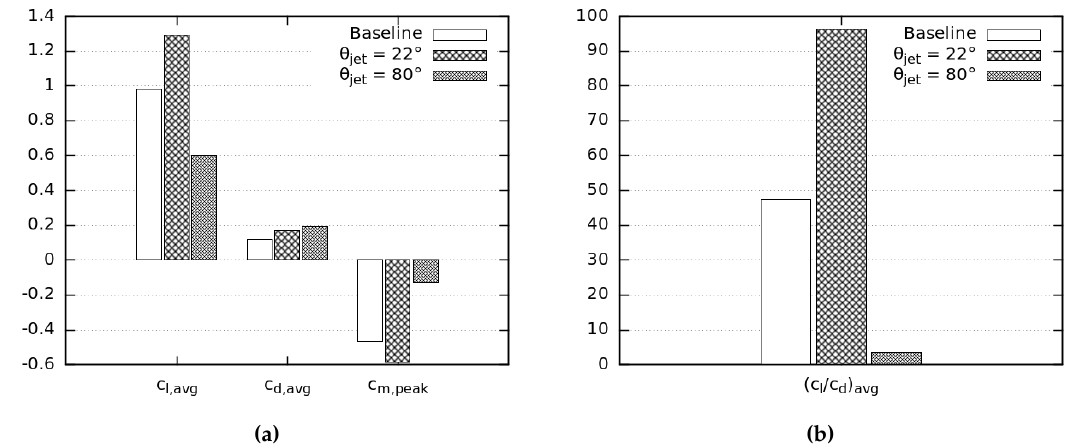
Figure 18. Lift (cycle-averaged), drag (cycle-averaged), the peak moment and the lift-to-drag ratio (cycle-averaged) of the pitching OA209 airfoil with and without steady-blowing jets. Ma = 0.3, Re = 1.15 M, c µ = 0.06, k = 0.05 and α = 13 ◦ ± 7 ◦